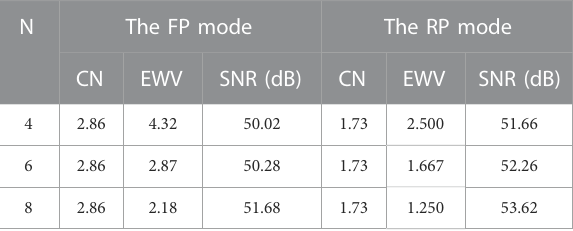
TABLE 1 The SNRs of measurement results in different con fi gurations.